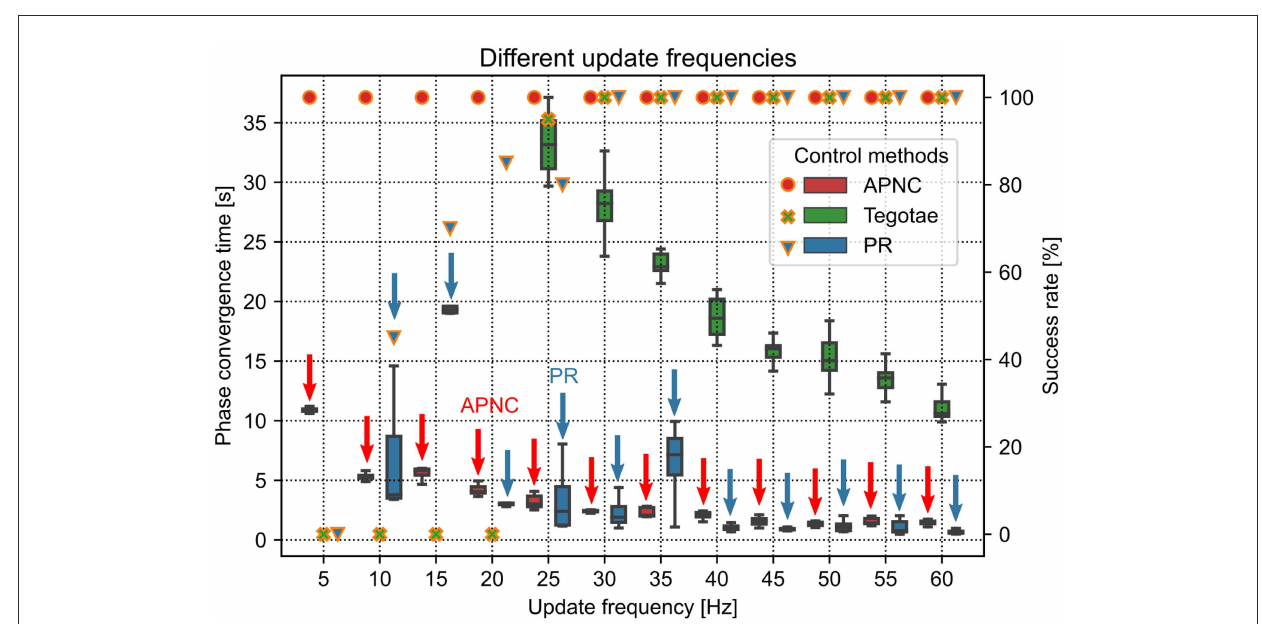
FIGURE5 Phase convergence time (represented by the boxes along with the left axis) and success rate (represented by markers along with the right axis) of the robot performing self-organized locomotion under three different control methods (APNC, Tegotae, and PR) for various update frequencies of the robot system. Red and blue arrows indicate the APNC and